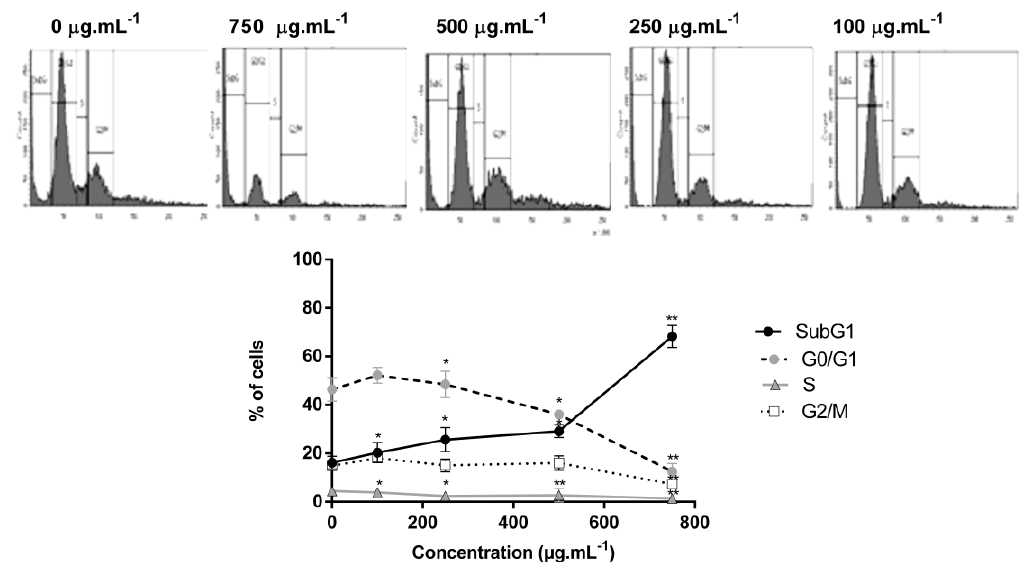
Figure 5. Flow cytometry analysis confirms that DM soxhlet extract of C. sinuosa increases the subG1 population in colon cancer cells at 24 h. Significant differences vs. control cells, comparing cell cycle phases (SubG1, G0/G1, S, G2/M), are indicated by * p < 0.05 and by ** p < 0.01 . Data values represent the mean ± SD (n = 2).